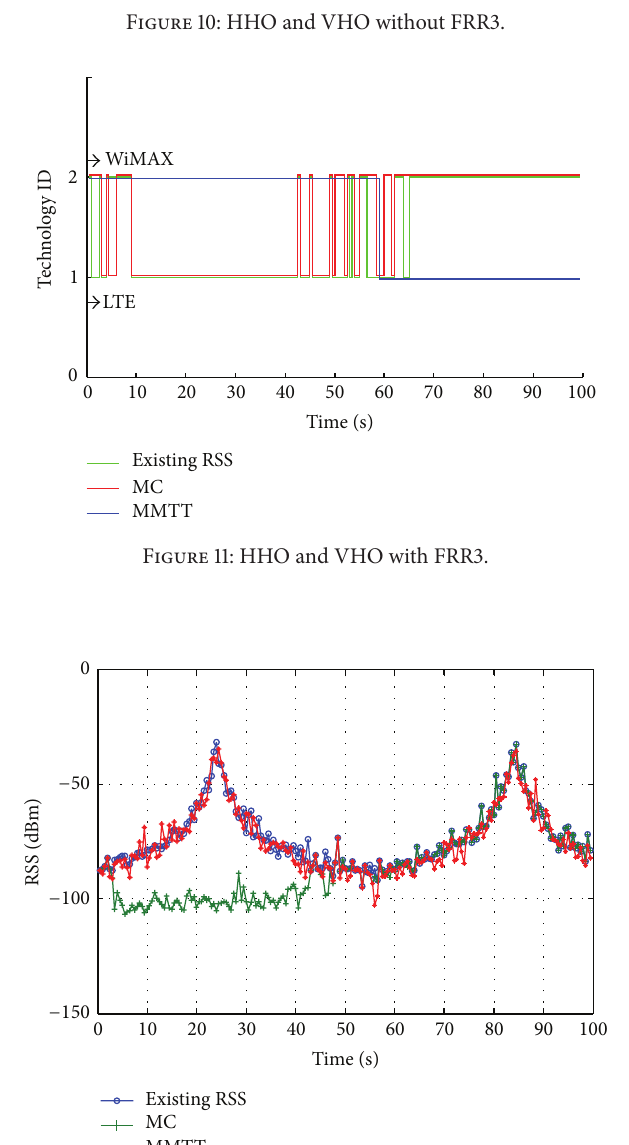
Figure 10: HHO and VHO without FRR3.